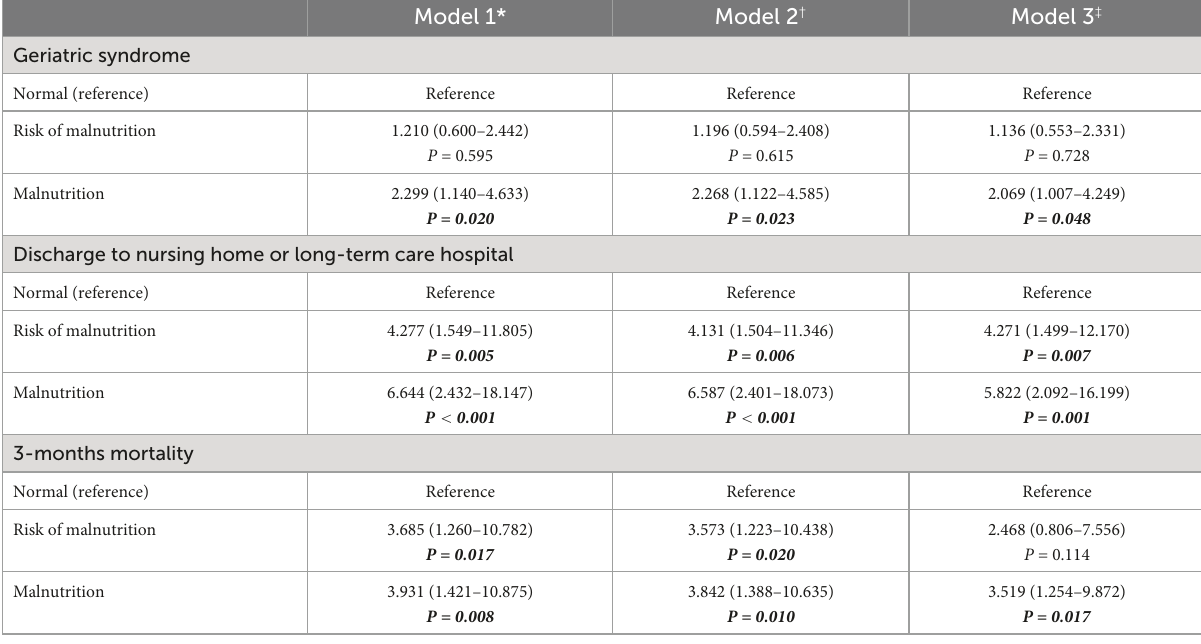
TABLE 2 Odds ratios for incident geriatric syndrome, discharge location and 3-months mortality according to nutritional status assessed by